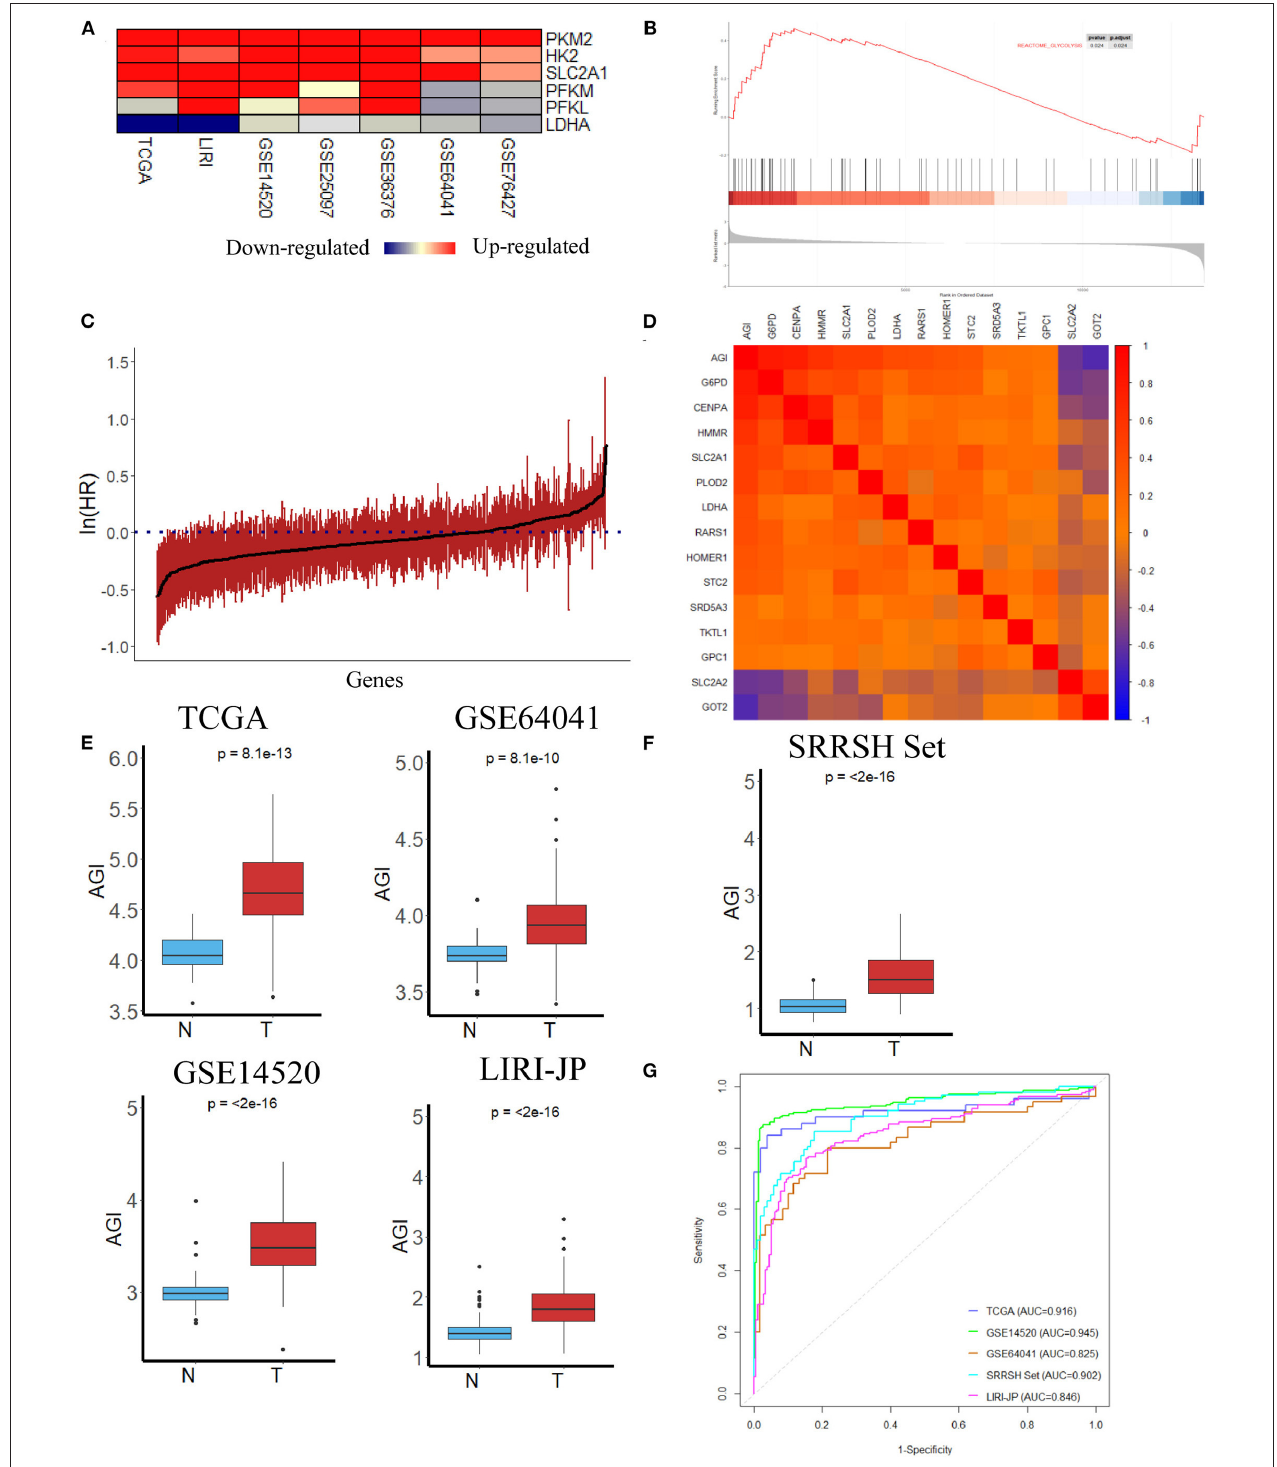
FIGURE 2 | Construction of the aerobic glycolysis index (AGI) model and validation of the AGI in tumor and normal tissues. (A) Heatmap of glycolysis-related gene expression in different datasets. (B) Gene Set Enrichment Analysis (GSEA) of the glycolysis pathway in GSE14520. (C) Bar plot showing the hazard ratio of glycolysis-related genes in The Cancer Genome Atlas (TCGA) cohort using the univariate Cox regression. The bars represent the 95% CI. (D) Correlation between the AGI and the selected signature genes in the TCGA cohort. (E) Boxplots showing AGI differences in normal and tumor tissues in the TCGA, GSE64041, GSE14520 and LIRI JP datasets. (F) Boxplots showing AGI differences in normal and tumor tissues in the SRRSH set. (G) Receiver operating characteristic (ROC) curves for tissue type prediction using the AGI as the predictor.